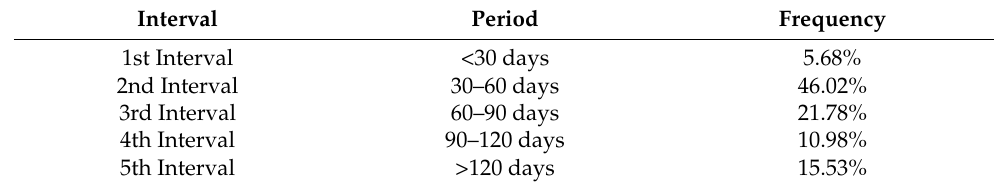
Table 2. Distribution of patients based on time intervals elapsed from the first positive COVID-19 test.